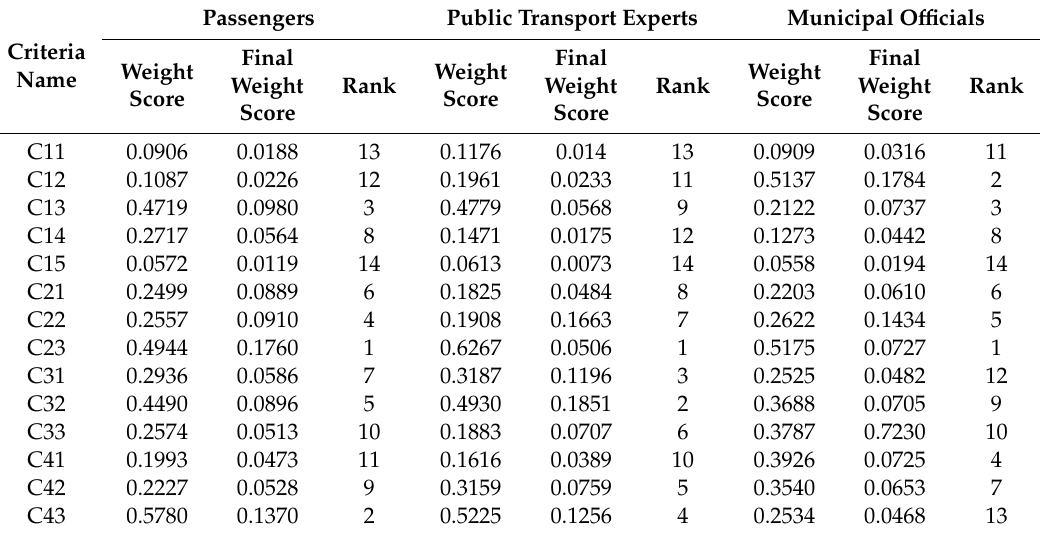
Table 8. The final weights and ranks for the factors in the second